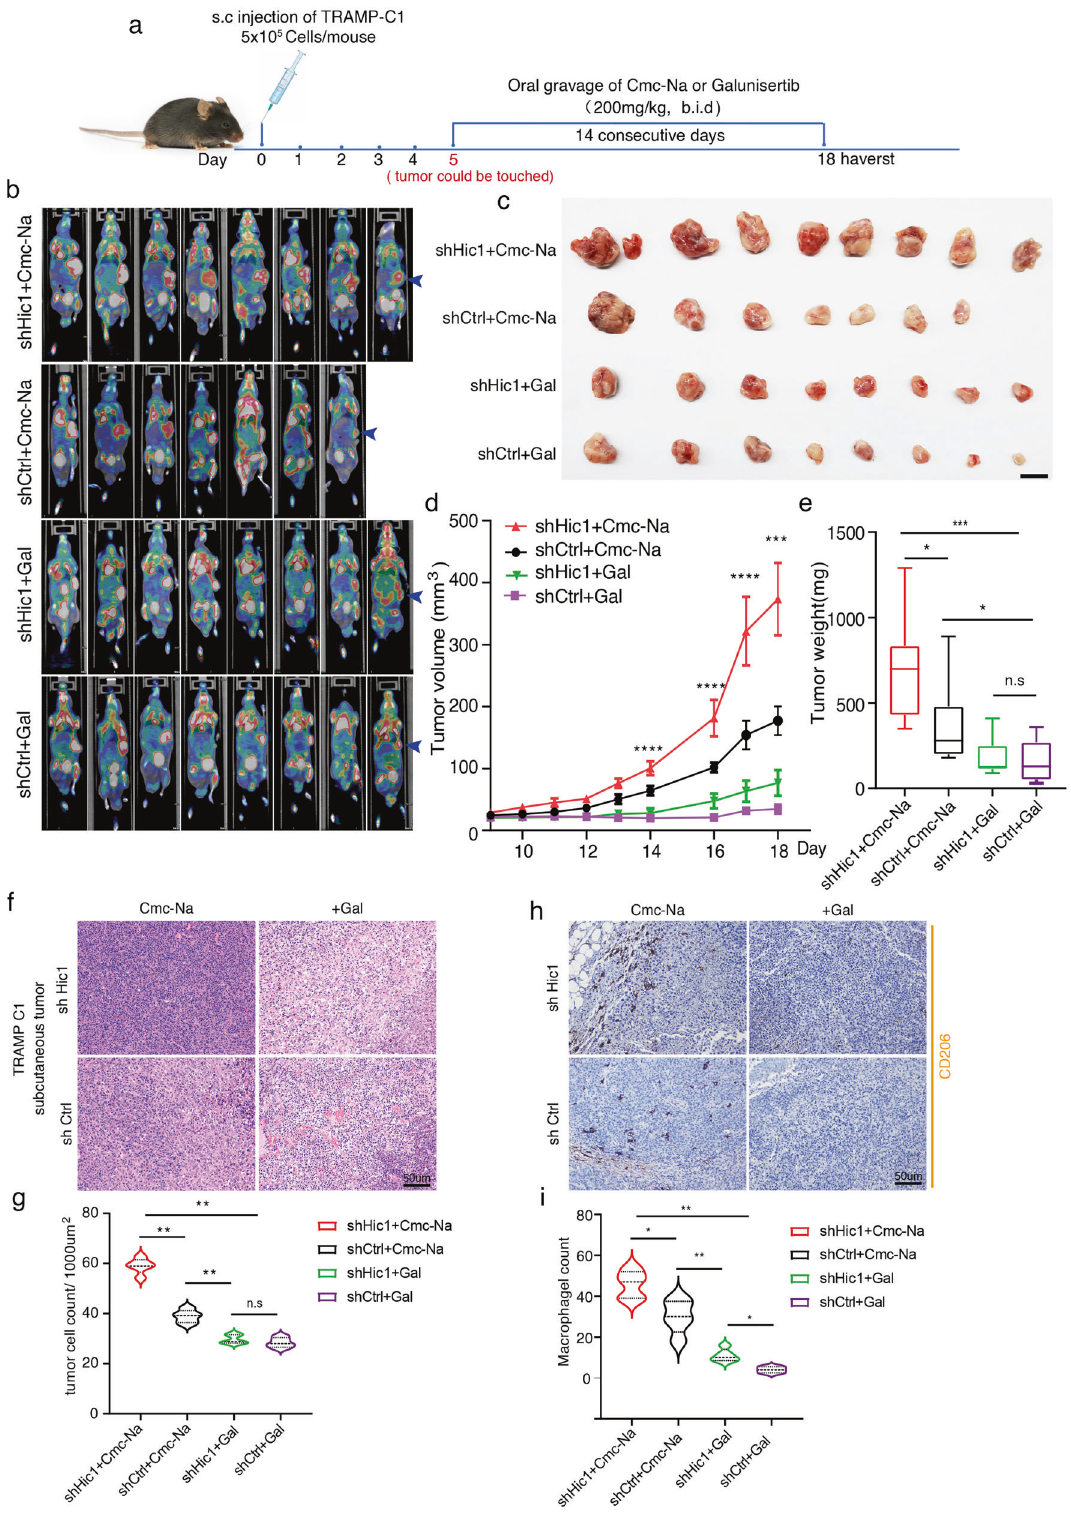
was further con fi rmed by quantitative analysis (Fig. 6b – e). However, when treated with Gal, both TRAMP-C1 (shHic1) and TRAMP-C1 (shCtrl) cell-derived tumor tissues exhibited signi fi - cant tumor growth inhibition and lower tumor weight, indicating that targeting TGF- β signaling was able to prevent tumor growth (Fig. 6c –